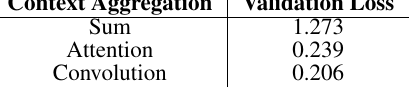
Table 1. Ablation on context aggregation method.